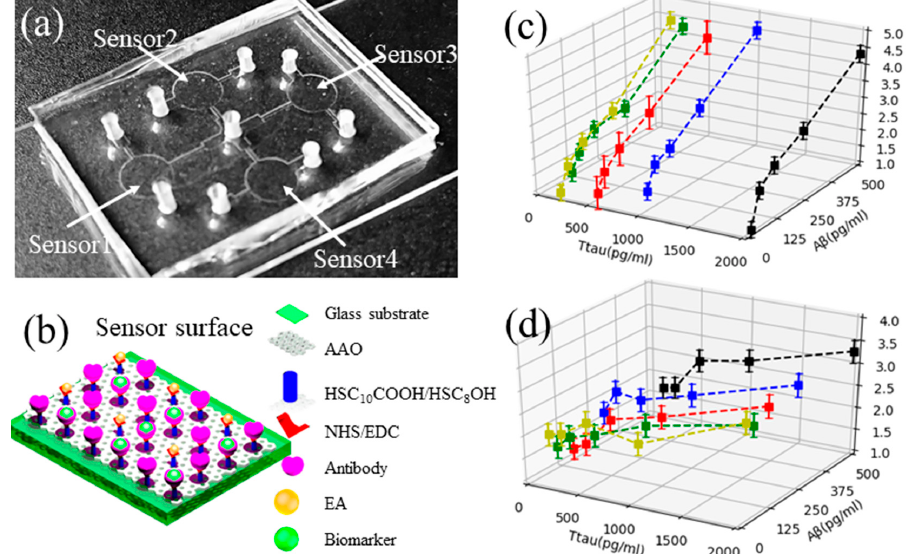
Figure 6. ( a ) Photo of fabricated sensors on chip for detecting A β 42 and T-tau; ( b ) sketch showing the functionalized sensor surface for detecting biomarkers; ( c ) measured transducing signals of A β 42 in A β 42-T-tau mixture using an A β 42-sensor and ( d ) measured transducing signals of T-tau in A β 420T-tau-mixture using a T-tau-sensor. Reproduced from reference [84] with permission from Elsevier.